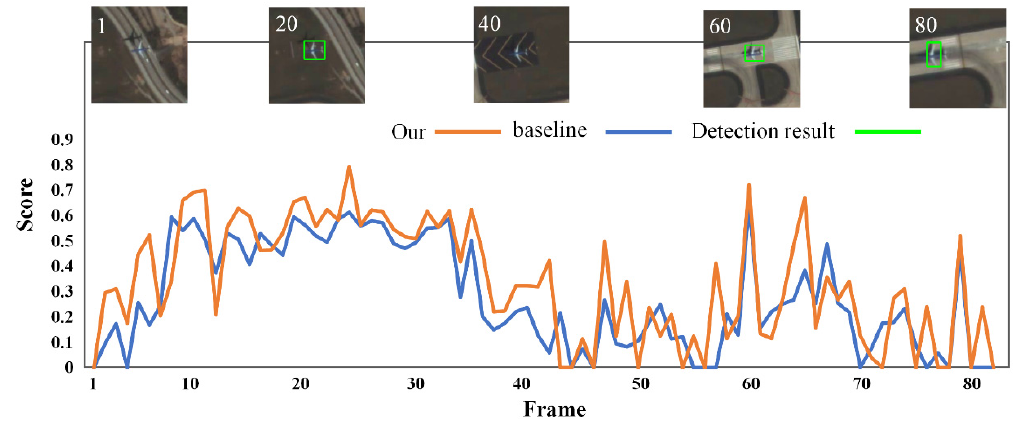
Figure 7. Statistical comparison of detection scores for high-speed aircraft inter-frame.